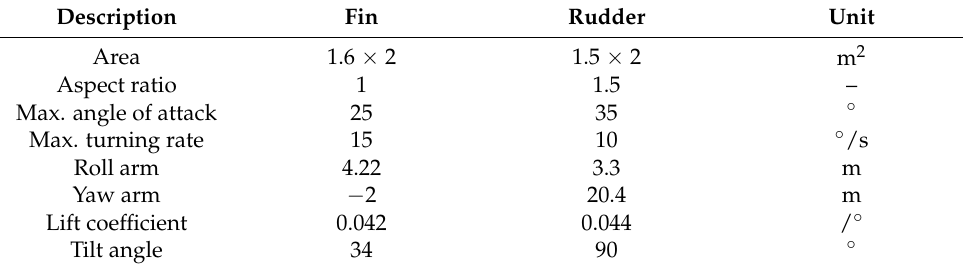
Table 2. Parameters of the fin and rudder.